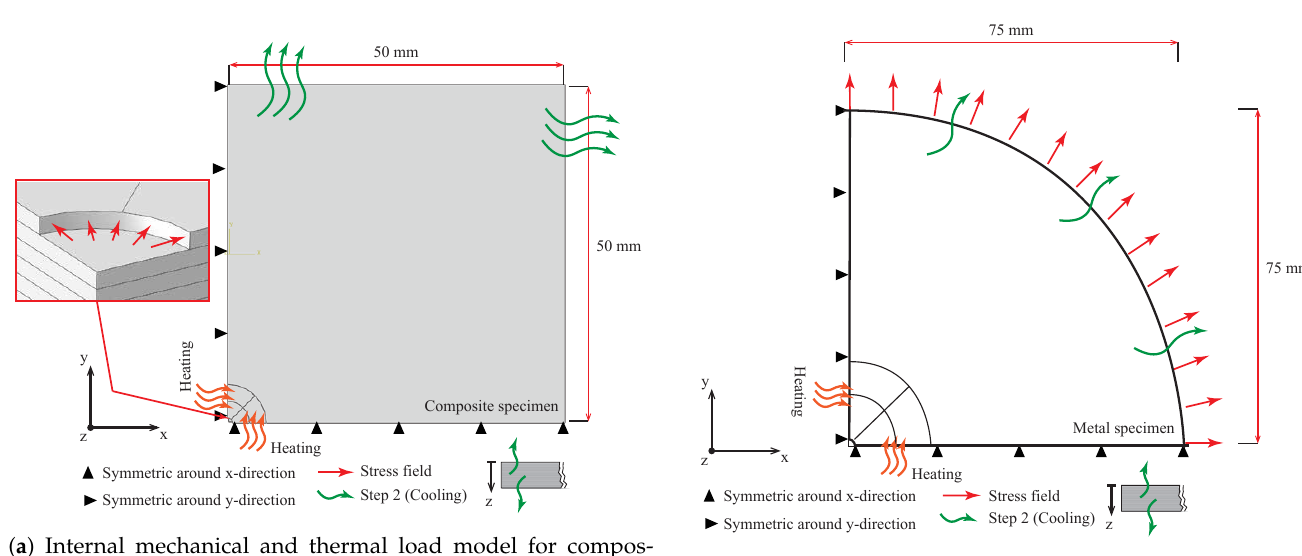
Figure 5. Internal mechanical and thermal load models.